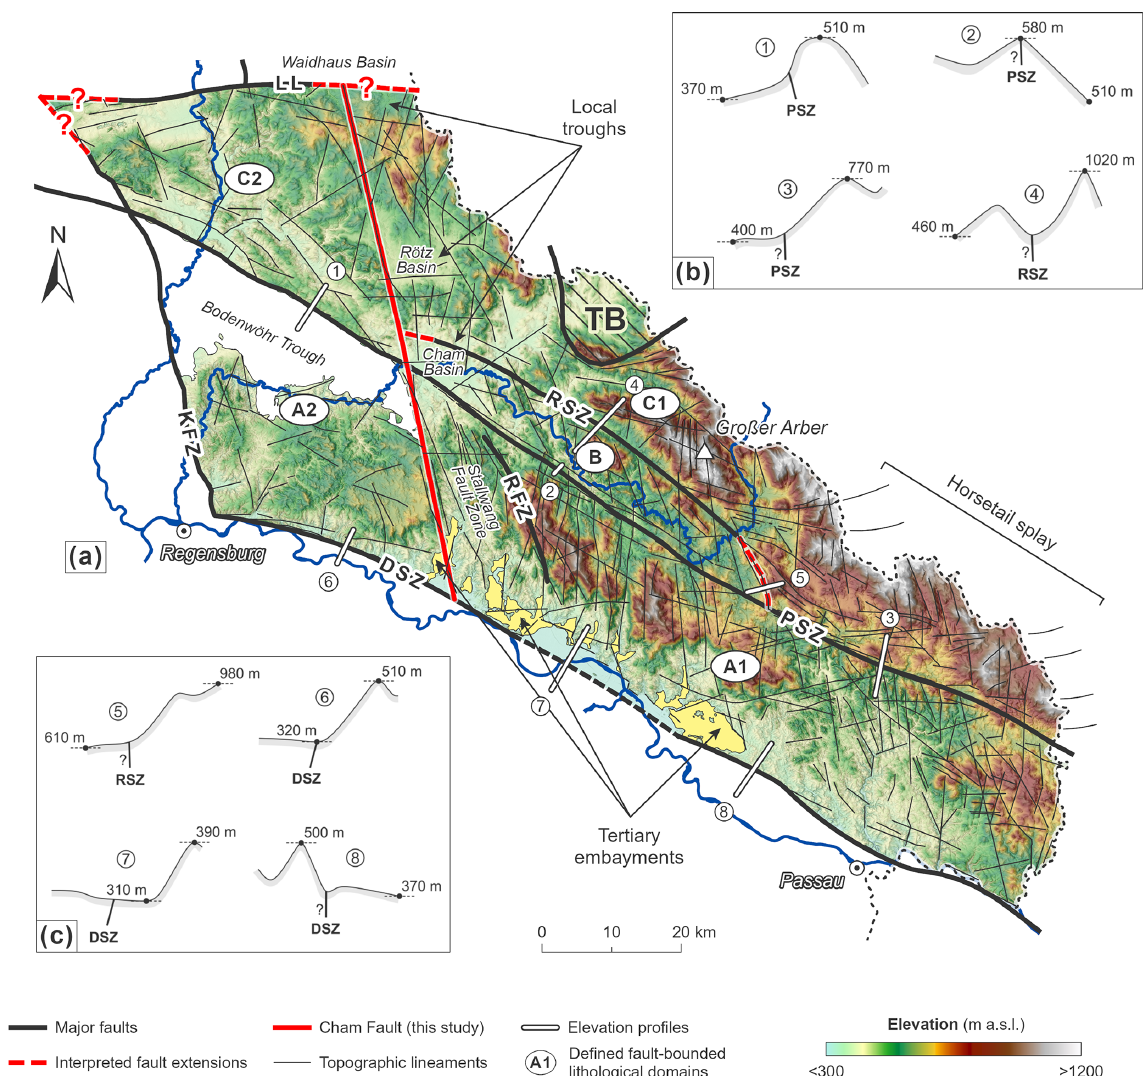
Figure 6. Lineament inventory of the study area. (a) DEM depicting lineament traces, major fault zones, and the interpreted Cham Fault. The locations of important topographic features like troughs and Tertiary embayments are outlined. Note that only higher-order lineaments are shown to maintain clarity. (b) – (c) Elevation profiles across the different topographic segments of the Pfahl, Runding, and Danube shear zones (viewing direction from southeast to northwest). Question marks indicate unknown dip directions of the associated faults. Fault zones: DSZ – Danube Shear Zone; KFZ – Keilberg Fault Zone; LL – Luhe Line; PSZ – Pfahl Shear Zone; RSZ – Runding Shear Zone; RFZ – Rattenberg Fault Zone. TB –